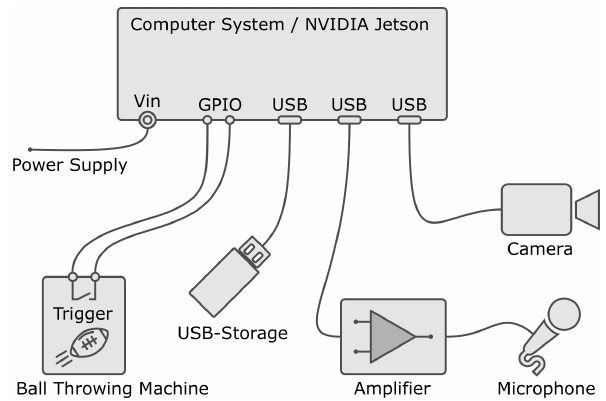
Figure 1. Blockdiagram of the audivisual recording